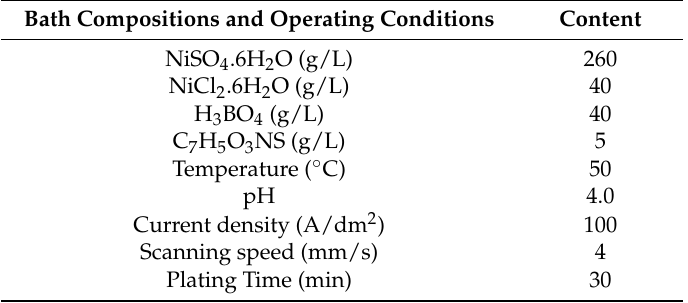
Table 2. Bath compositions and operating conditions for the jet